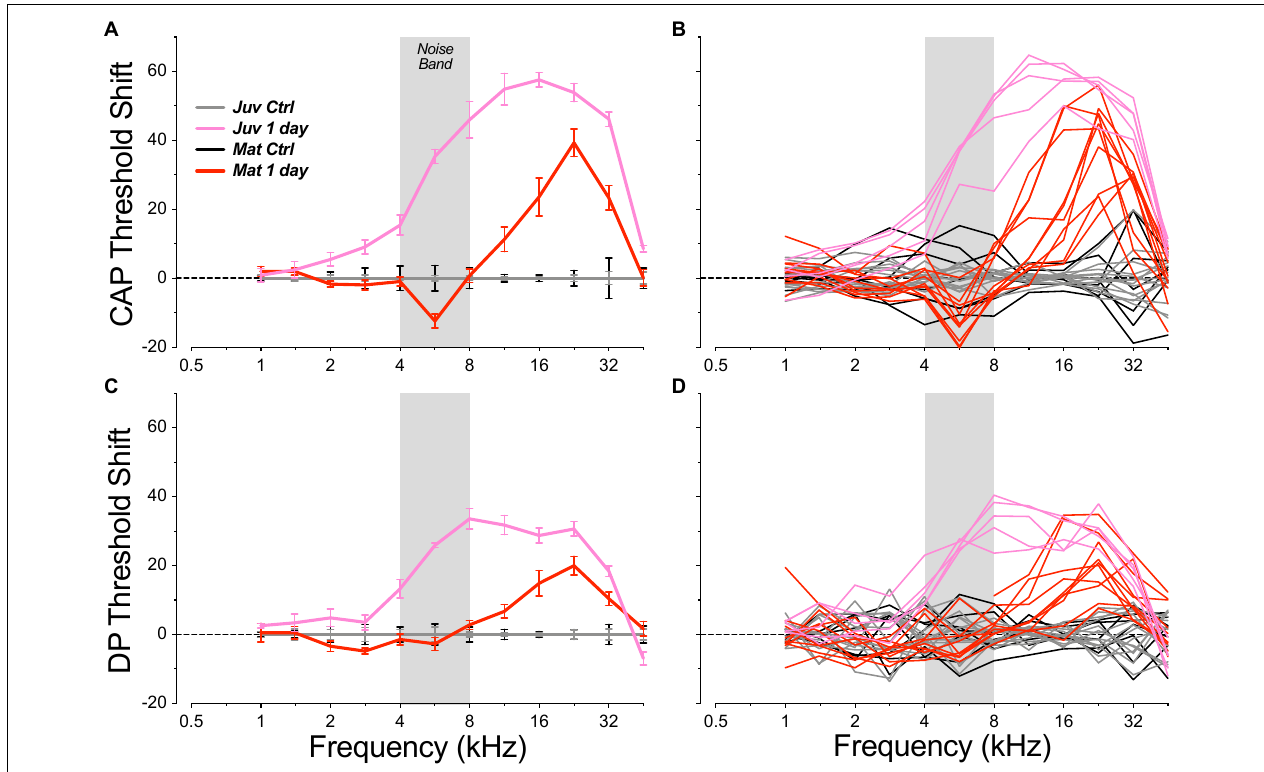
FIGURE 3 | Acute threshold shifts, measured 1 day post exposure, were smaller in mature guinea pigs than in the juvenile animals from a prior report (Hickman et al., 2020). Threshold shifts are measured re mean control data for the same age group (see Figure 2 ). Data are shown for CAPs (A,B) and for DPOAEs (C,D) , and each metric is plotted for individual animals (B,D) and as group means ± SEMs (A,C) . The gray bar indicates the passband of the noise exposure used to create synaptopathy. Group sizes were: mature control n = 7 ears of 4 animals, juvenile control n = 14 ears of 7 animals, mature 1 day n = 10 ears of 5 animals, juvenile 1 day n = 5 ears of 3